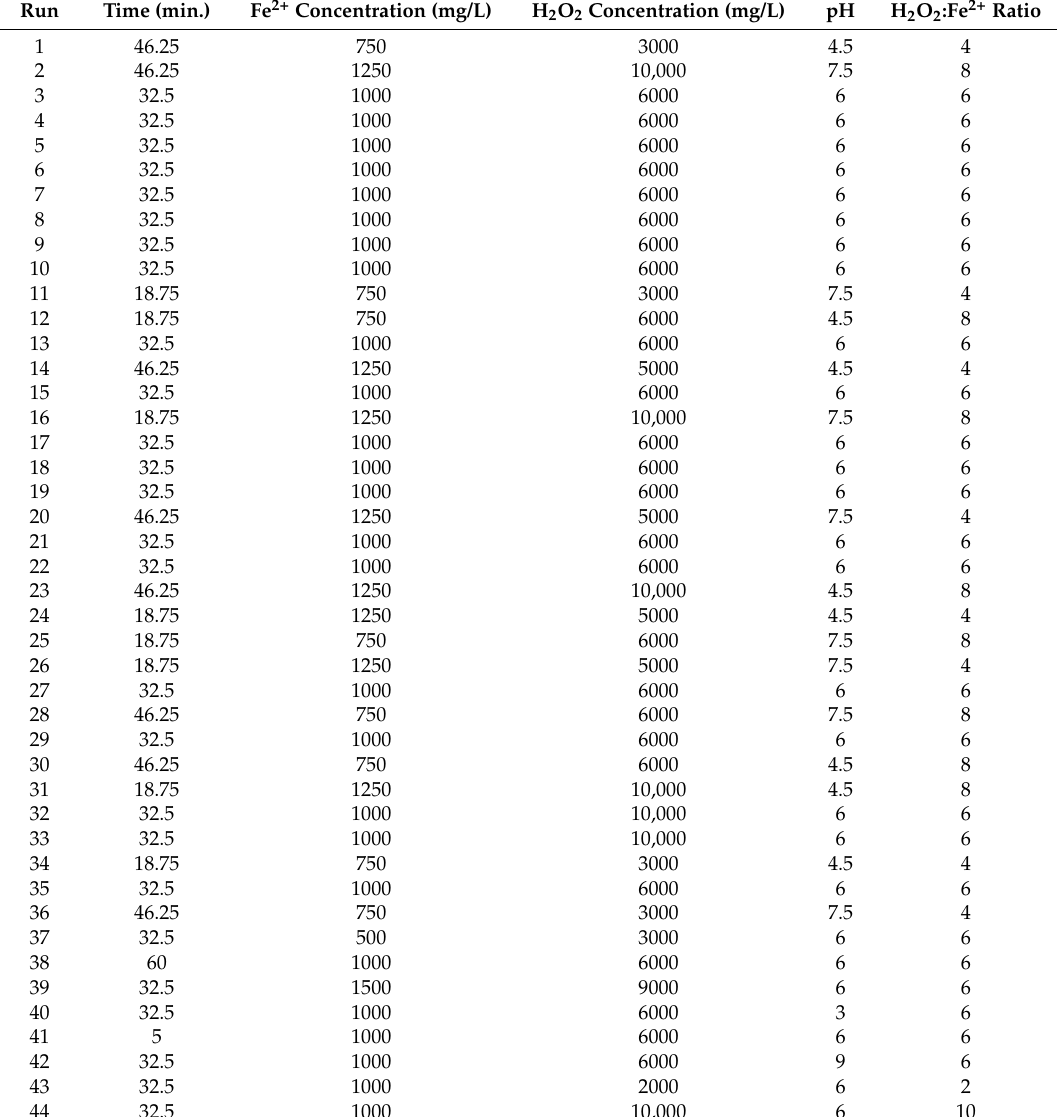
Table 2. Parameters of artificial neural network (ANN) experiments.